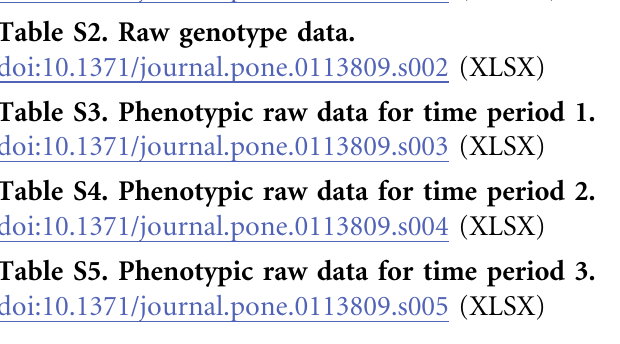
Table S1. Primer and PCR details for S. fontinalis microsatellites used in this study. Table S2. Raw genotype data. Table S3. Phenotypic raw data for time period 1. Table S4. Phenotypic raw data for time period 2. Table S5. Phenotypic raw data for time period